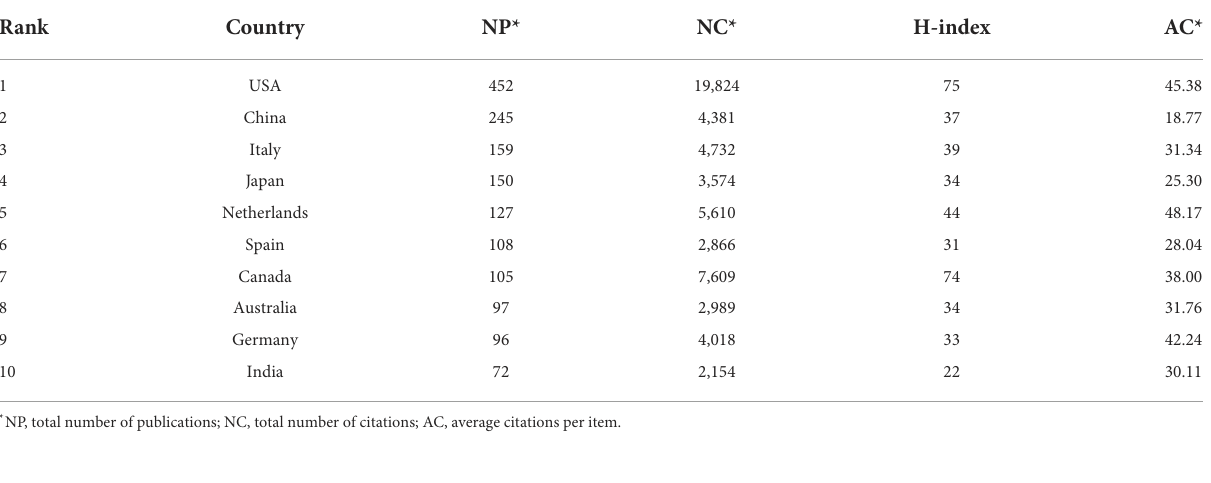
TABLE 1 Topmost 10 productive country in the field of LF antibacterial research.